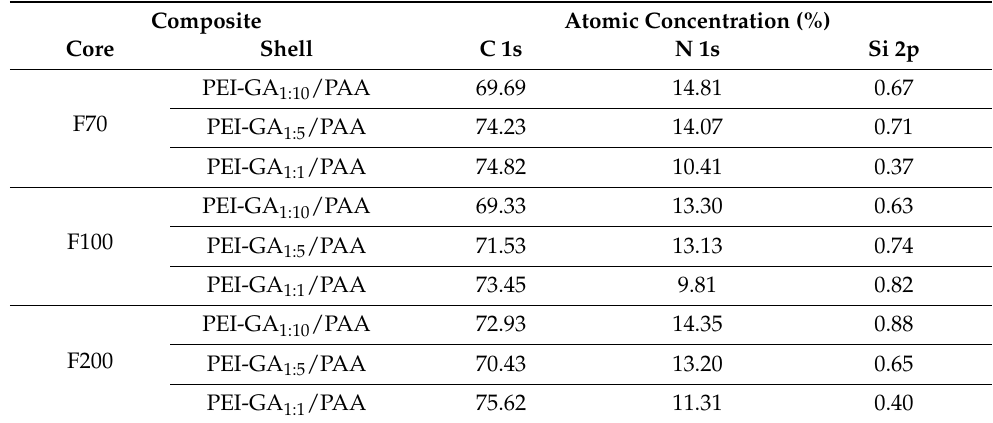
Table 2. Atomic concentrations of carbon, nitrogen, and silicon on the surface of the composites.